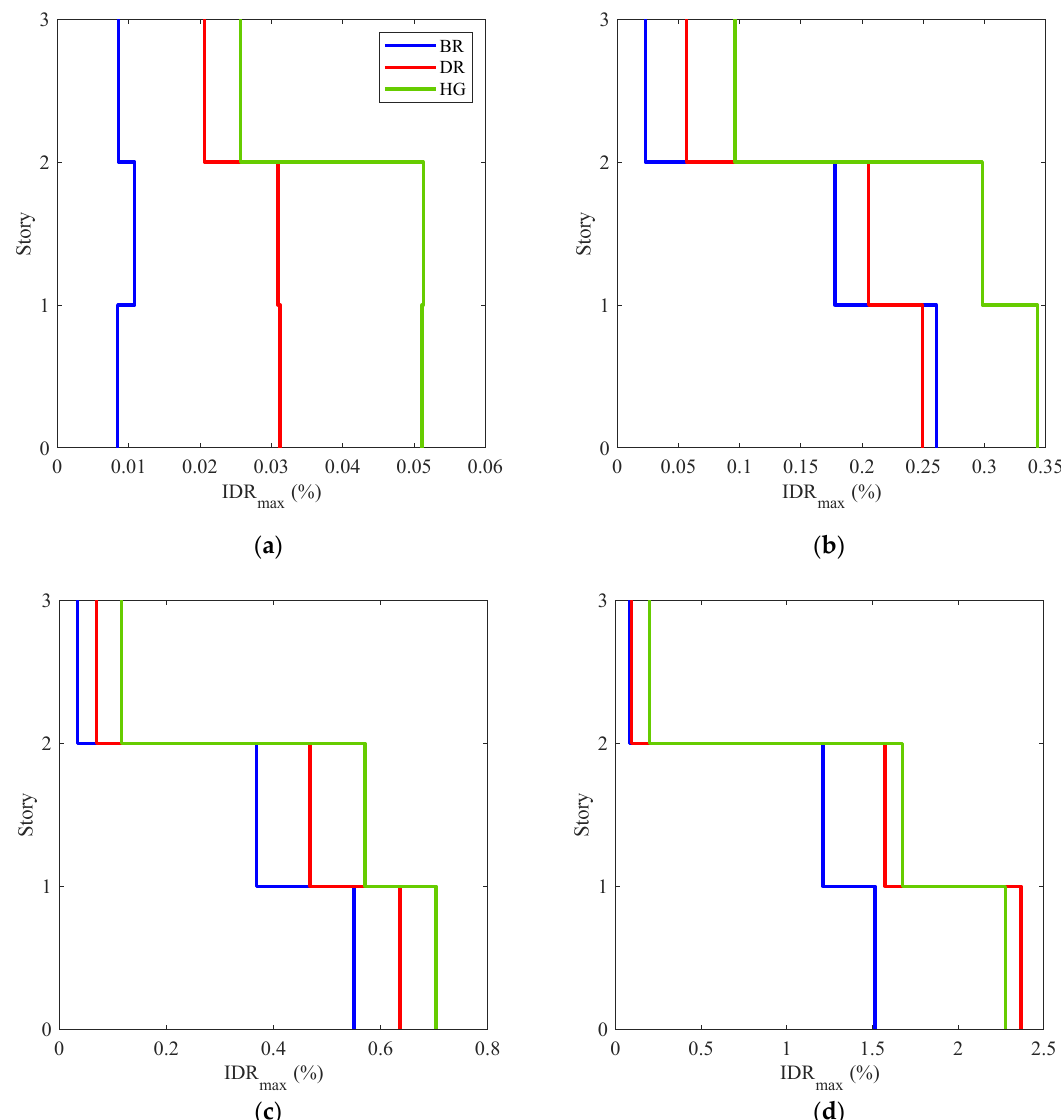
Figure 9. Interstory drift profiles in the longitudinal direction for PGA corresponding to ( a ) 0.1 g, ( b ) 0.4 g, ( c ) 0.6 g, ( d ) 1.2 g.